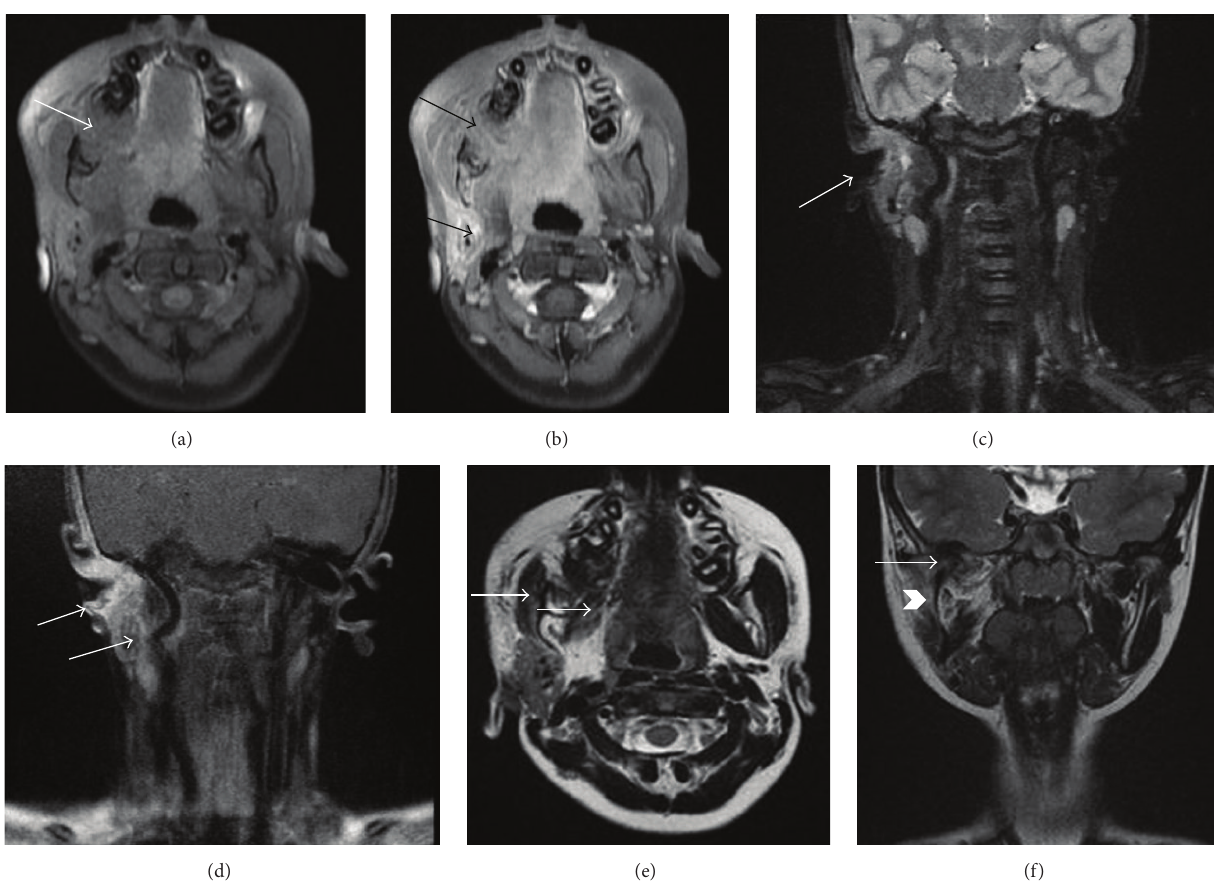
Figure5:(a) PrecontrastT1Waxial imageshowingprimarymass(arrow)inthealveolarprocessofmaxillaandmandiblewithbonyexpansion, (b) postcontrast T1W fat saturated axial image showing enhancing intraosseous mass in maxilla and mandible, the parotid, and infratemporal fossa (arrows), (c) coronal STIR image showing narrow external auditory canal (arrow), (d) coronal postgadolinium image showing mass in infratemporal fossa, the parotid, and external auditory canal (arrows), (e) axial T2W image showing hypoplastic pterygoid and masseter muscles (arrows), and (f) coronal T2W image showing concave right mandibular ramus (chevron) and hypoplastic condyle with extension of mass into the TMJ